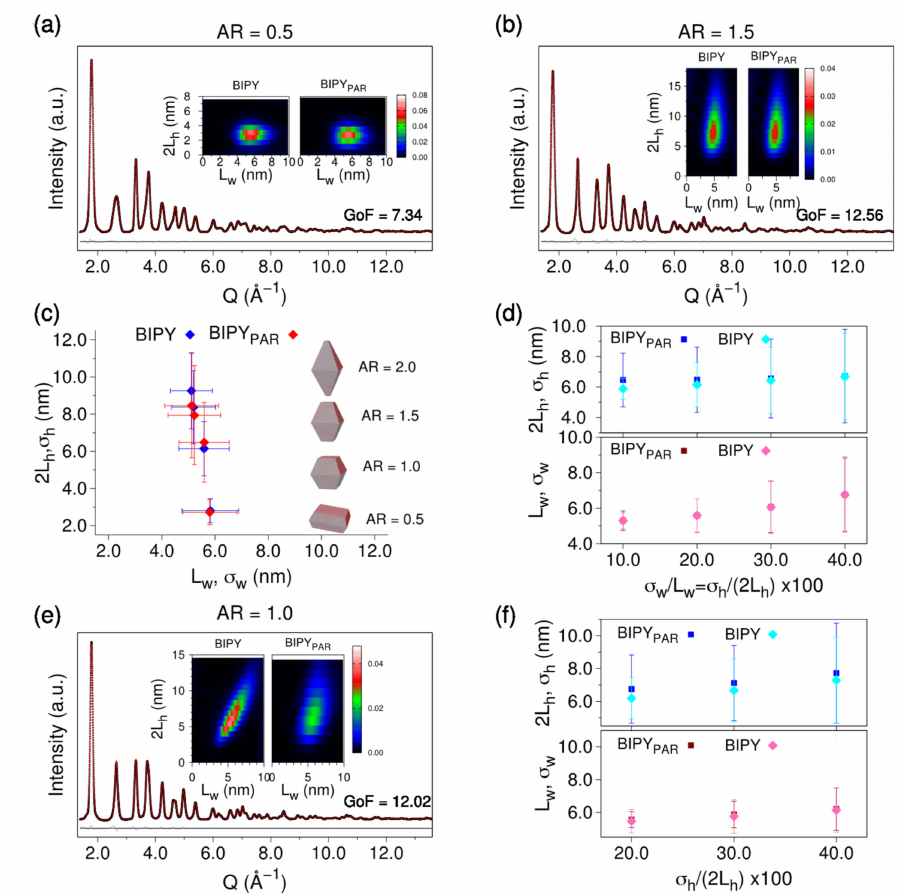
Figure 3. Analysis of X-ray pattern simulations from anatase bipyramids (BIPY) NCs fitted using prismatic NCs, from which relevant parameters of the parent prismatic morphology (BIPY PAR ) are extracted. ( a , b , e ) BIPY simulations (black dots, Poisson noise with S / N ≈ 700), best DSE fits (red traces) obtained using a bivariate population of tetragonal prisms by adjusting size and shape parameters. As these curves closely superimpose, the absolute residual trace (in gray), shown at the bottom, addresses the tiny mismatch between them. BIPY simulations correspond to < AR > = < 2L h >/< L w > = 0.5 ( a ), < AR > = 1.5 ( b ), < AR > = 1.0 ( e ), 20% relative dispersion ( σ h /< 2L h > = σ w /< L w > = 0.2 , ϕ B = 0 ◦ ) along the two growth directions in ( a , b ), and σ h /< 2L h > = 0.4 , σ w /< L w > = 0.1, ϕ B = 30 ◦ in ( e ). Insets in ( a , b , e ) show the color-encoded (mass based) BIPY 2D maps and those recovered by the BIPY PAR model; ( c ) comparison of average size, shape, and dispersion parameters of BIPY at increasing < AR > (blue diamonds) with BIPY PAR -retrieved values (red diamonds) and fixed polydispersity. Horizontal and vertical bars represent the standard deviations of the lognormal distributions ( σ h = 0.2 < 2L h > and σ w = 0.2 < L w > in the BIPY population). The numerical outcomes of this plot are synoptically reported in Table A1; ( d , f ) BIPY and BIPY PAR size and size dispersion parameters at increasing σ h /< 2L h > values, at ϕ B = 0 ◦ ( d ) and ϕ B = 30 ◦ ( f ). In both panels, results about L w , σ w from BIPY PAR models